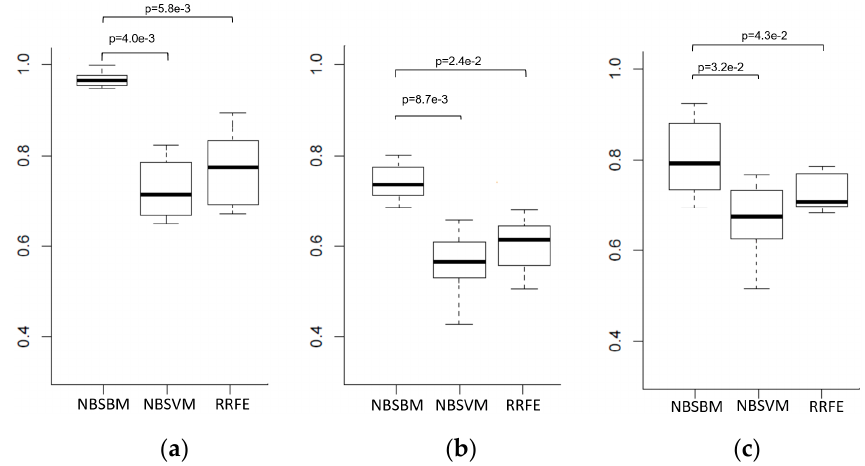
Figure 4. Performance comparison among NBSBM, network-based SVM, and SVM-FREE in terms of average AUC in predicting ( a ) prostate cells’ response to Dasatinib, ( b ) Breast Cancer Patients’ response to Tamoxifen therapy, and ( c ) 789 cancer cells’ response to Dasatinib. The Wilcoxon rank-sum test was used to examine whether the AUCs obtained by two approaches were different.